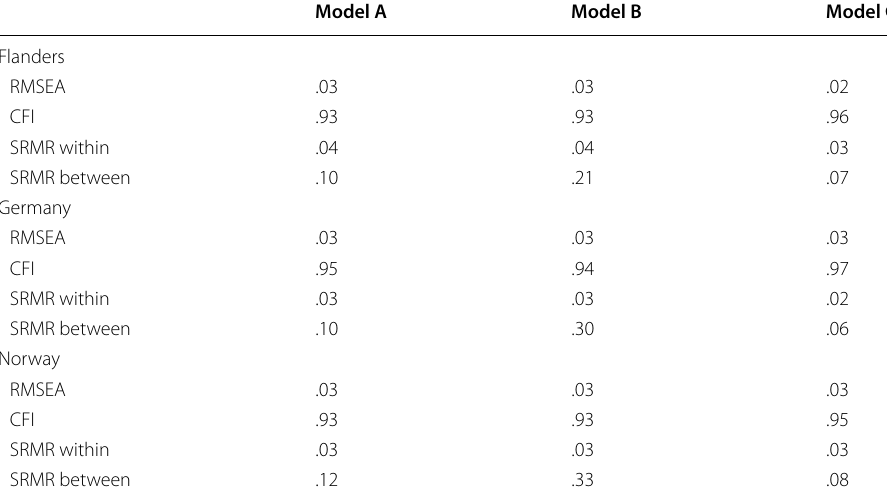
Table 4 Model fit indices for different CFA models